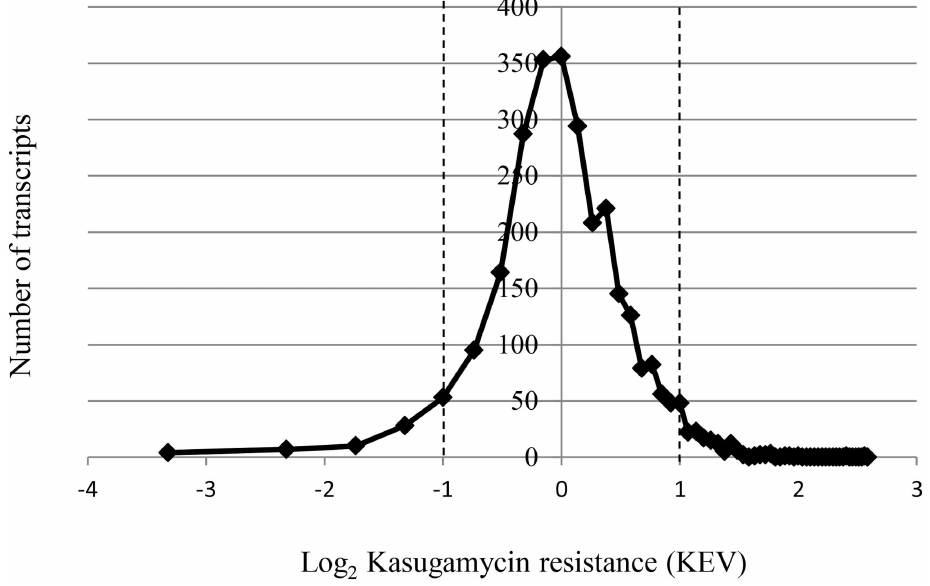
Fig 3. The distribution of Kasugamycin resistance in the translatome of E . coli . The KEV value representing a quantitativevalue of the degreeof Kasugamycin resistancewas calculatedfor each of the 2801 analyzed E . coli transcripts as explainedin the text. The KEV values were transformed into log 2 values, and the number of transcripts was plotted againstthe